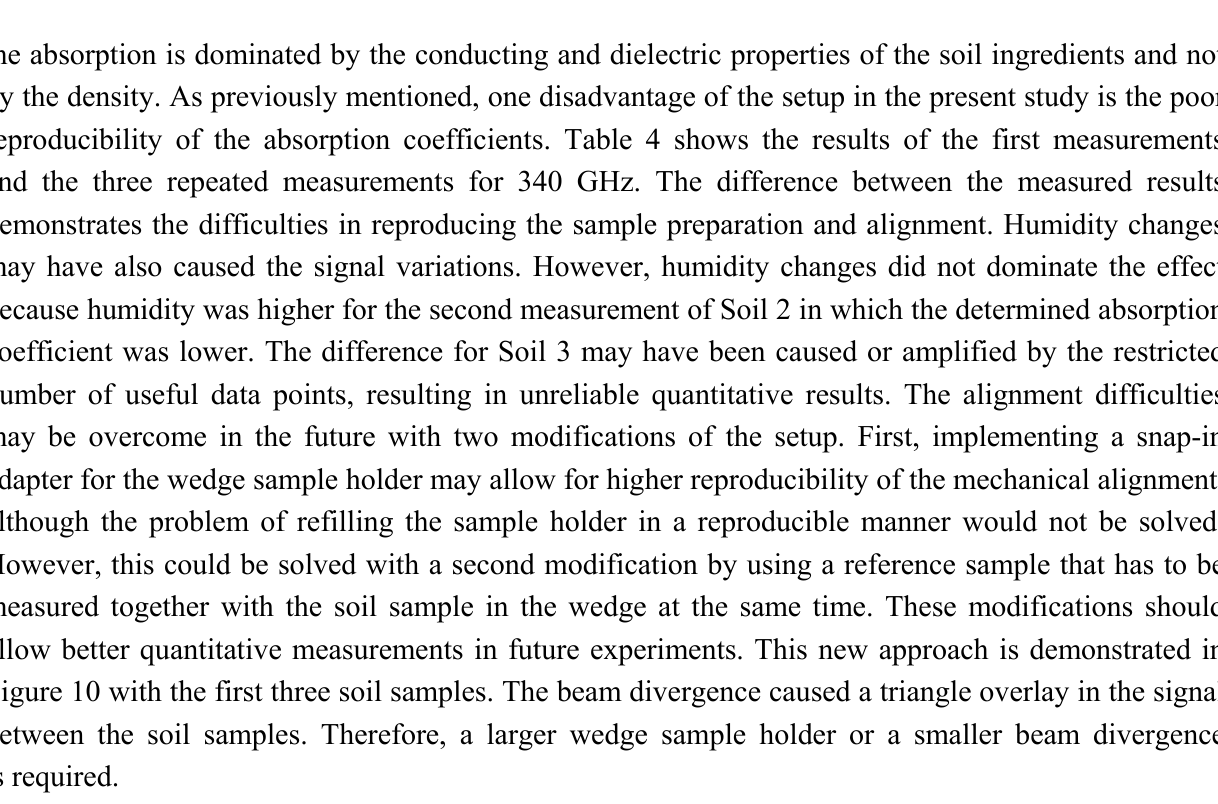
Figure 9. (a) Absorption coefficient versus the water content; (b) Absorption coefficient versus the organic matter; (c) Absorption coefficient versus the particle content of the 0.5–1.0 mm